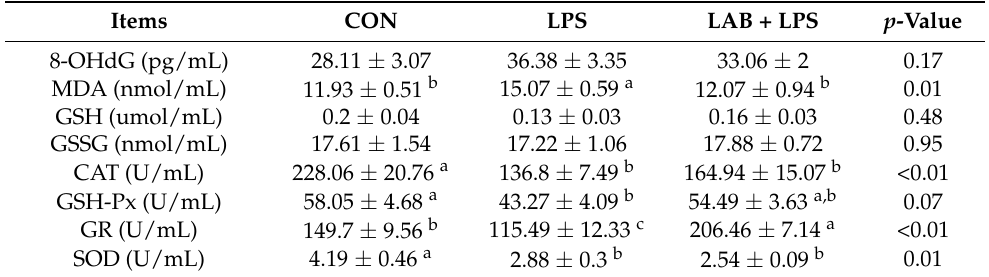
Table 4. The effects of LAB supplementation on the serum oxidative statuses of weaned piglets. Items CON LPS LAB + LPS p